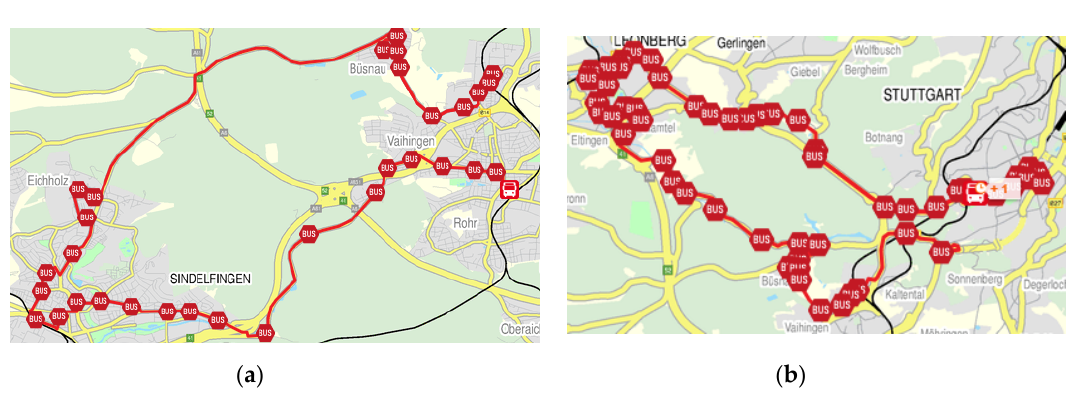
Figure A1. Geographical itinerary of line 84 ( a ) and line 92 ( b ). Bus stops are marked.